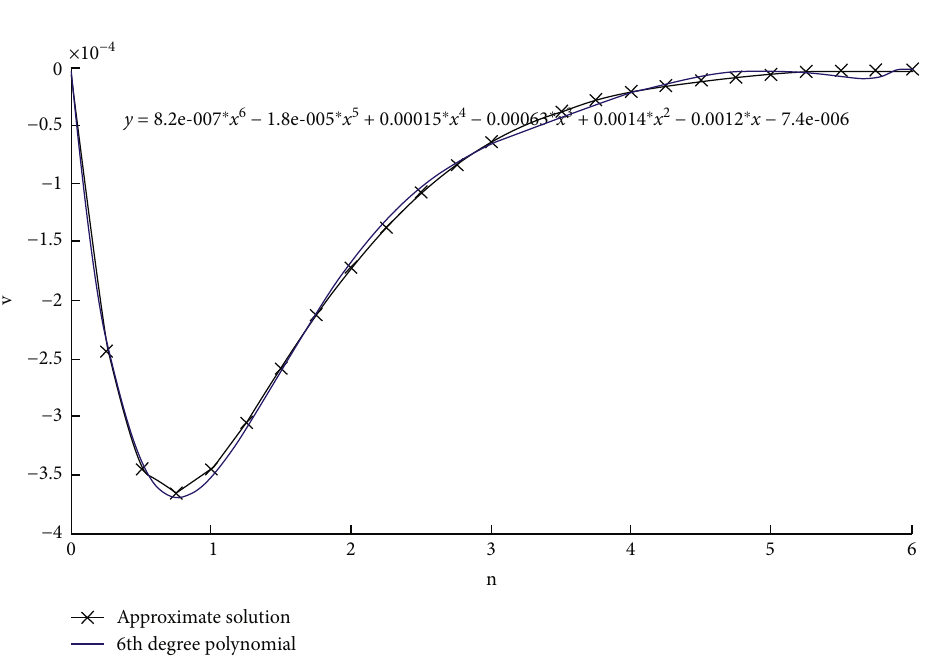
Figure 3: Sixth-degree polynomial fi t with imaginary part of velocity pro fi